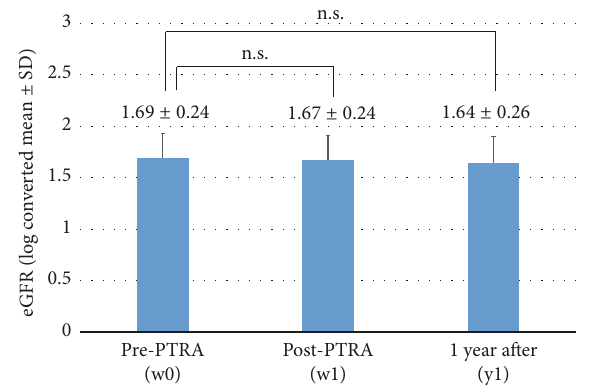
Figure 2: Change in eGFR. eGFR was not improved after PTRA. PTRA: percutaneous transluminal renal angioplasty; eGFR: esti- mated glomerular filtration rate; SD: standard deviation. ∗ Paired 𝑡 - tests were performed after log conversion of the